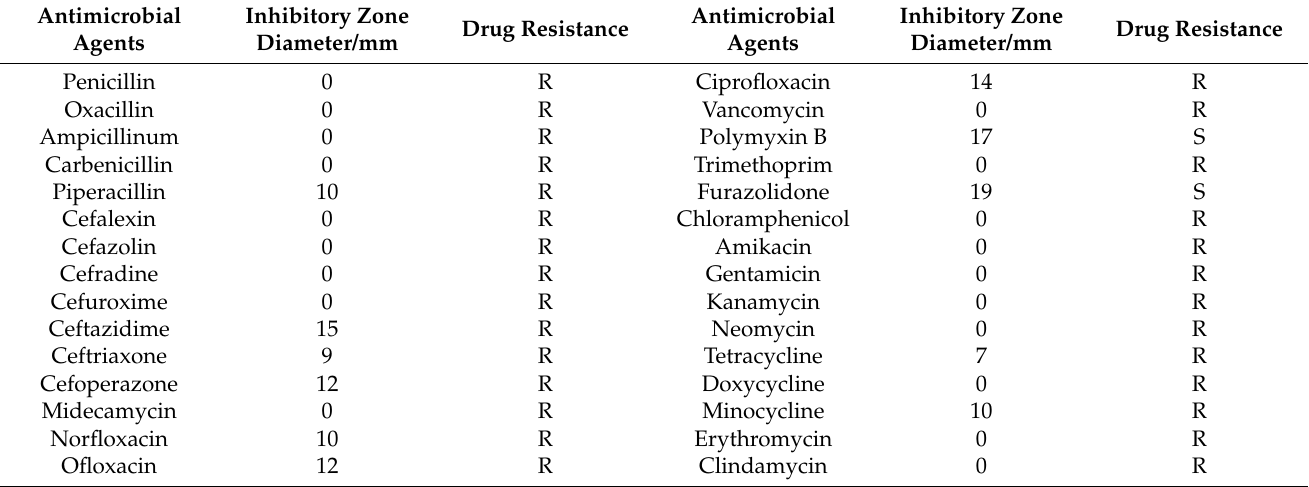
Table 3. Results of KPHN001 drug sensitivity